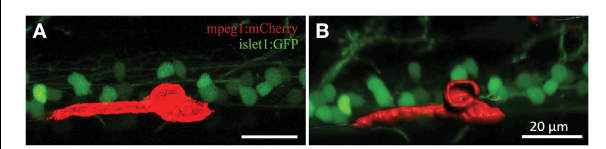
FIGURE 7 | 3D rendering demonstrates dynamic morphological features of activated microglia. Confocal live-imaging alone provides basic morphometric information of microglia phagocytosing an UV-ablated spinal neuron (A) . Imaris 3D rendering of this same single microglia revealed the formation of a phagosome-like structure (B) , which presumably facilitates engulfment of the neuronal remnants. Supplementary Videos 5 , 6 show the time-lapse videos of this process for comparison. Scale bars = 20 µ